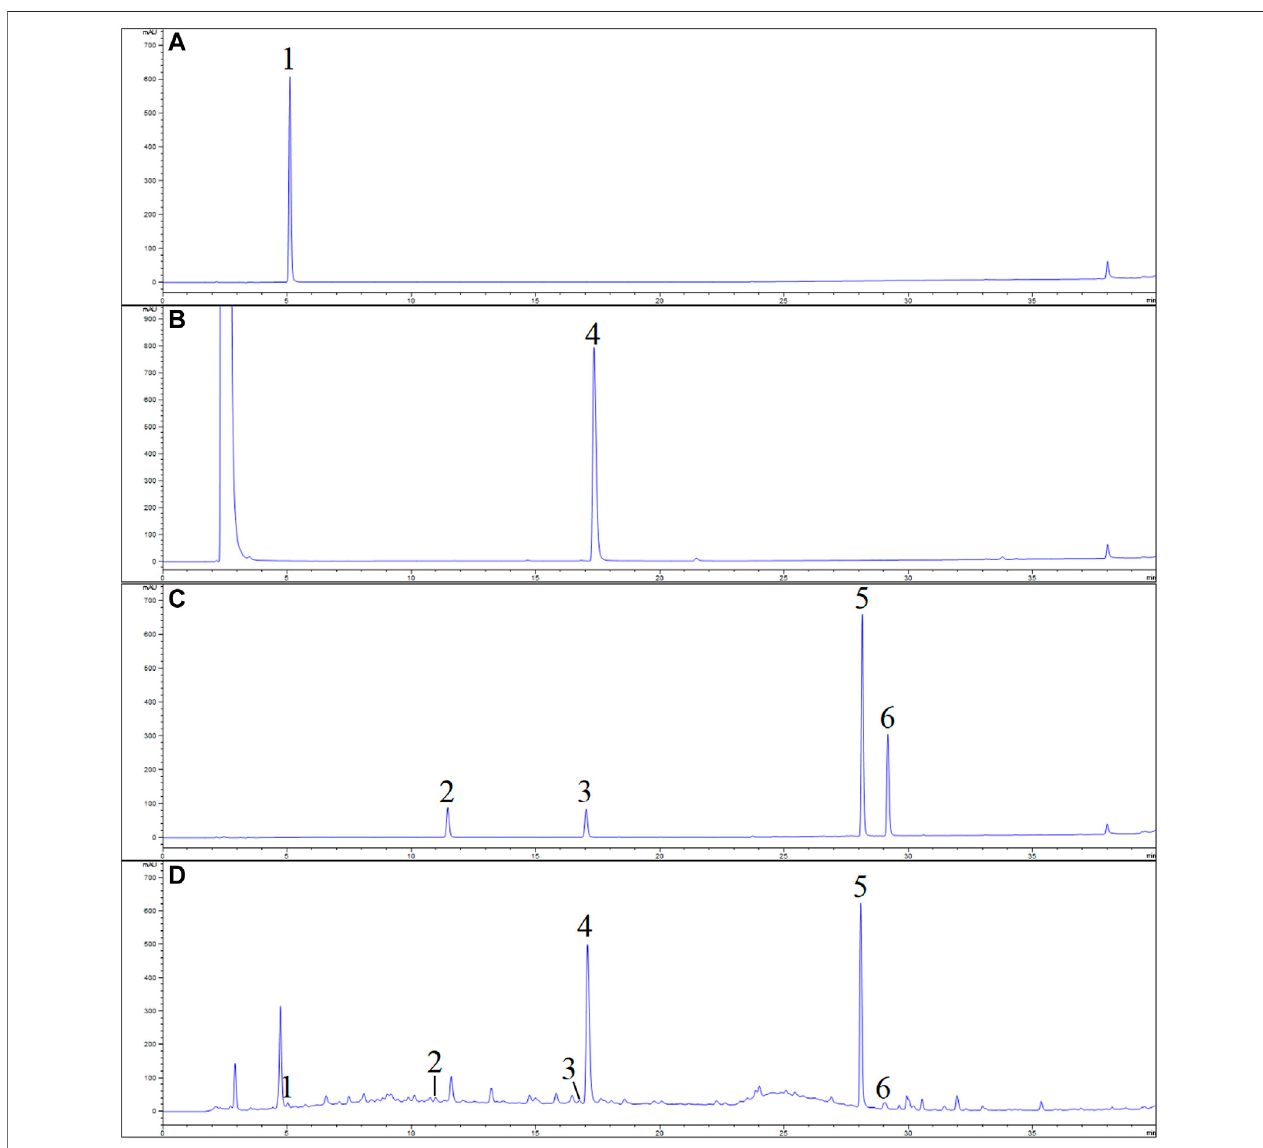
FIGURE4| UPLCchromatogramof Rubuschingii var. suavissimus andthereferencesolutions (A) gallicacid; (B) ellagicacid; (C) mixedreferencecompounds; (D) sample. 1) Gallic acid, 2) caffeic acid, 3) rutin, 4) ellagic acid, 5) rubusoside, and 6) kaempferol.